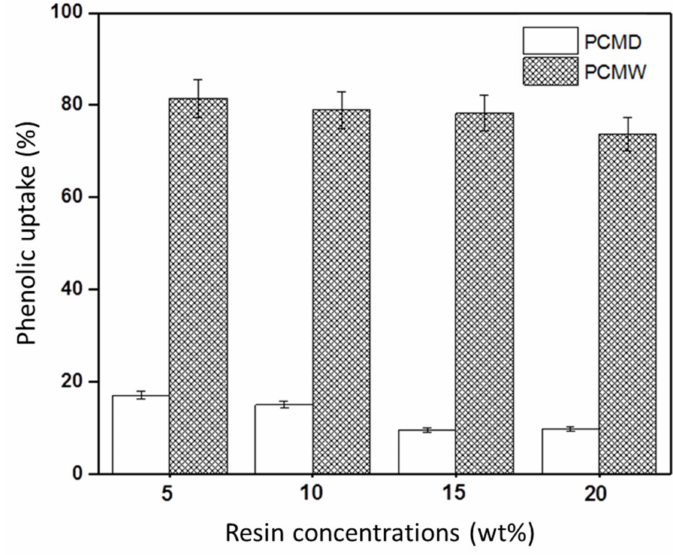
Figure 2. Synthesized PF uptakes at different concentrations in wet phenolic cellulose membrane (PCMW) and dry phenolic cellulose membrane (PCMD).